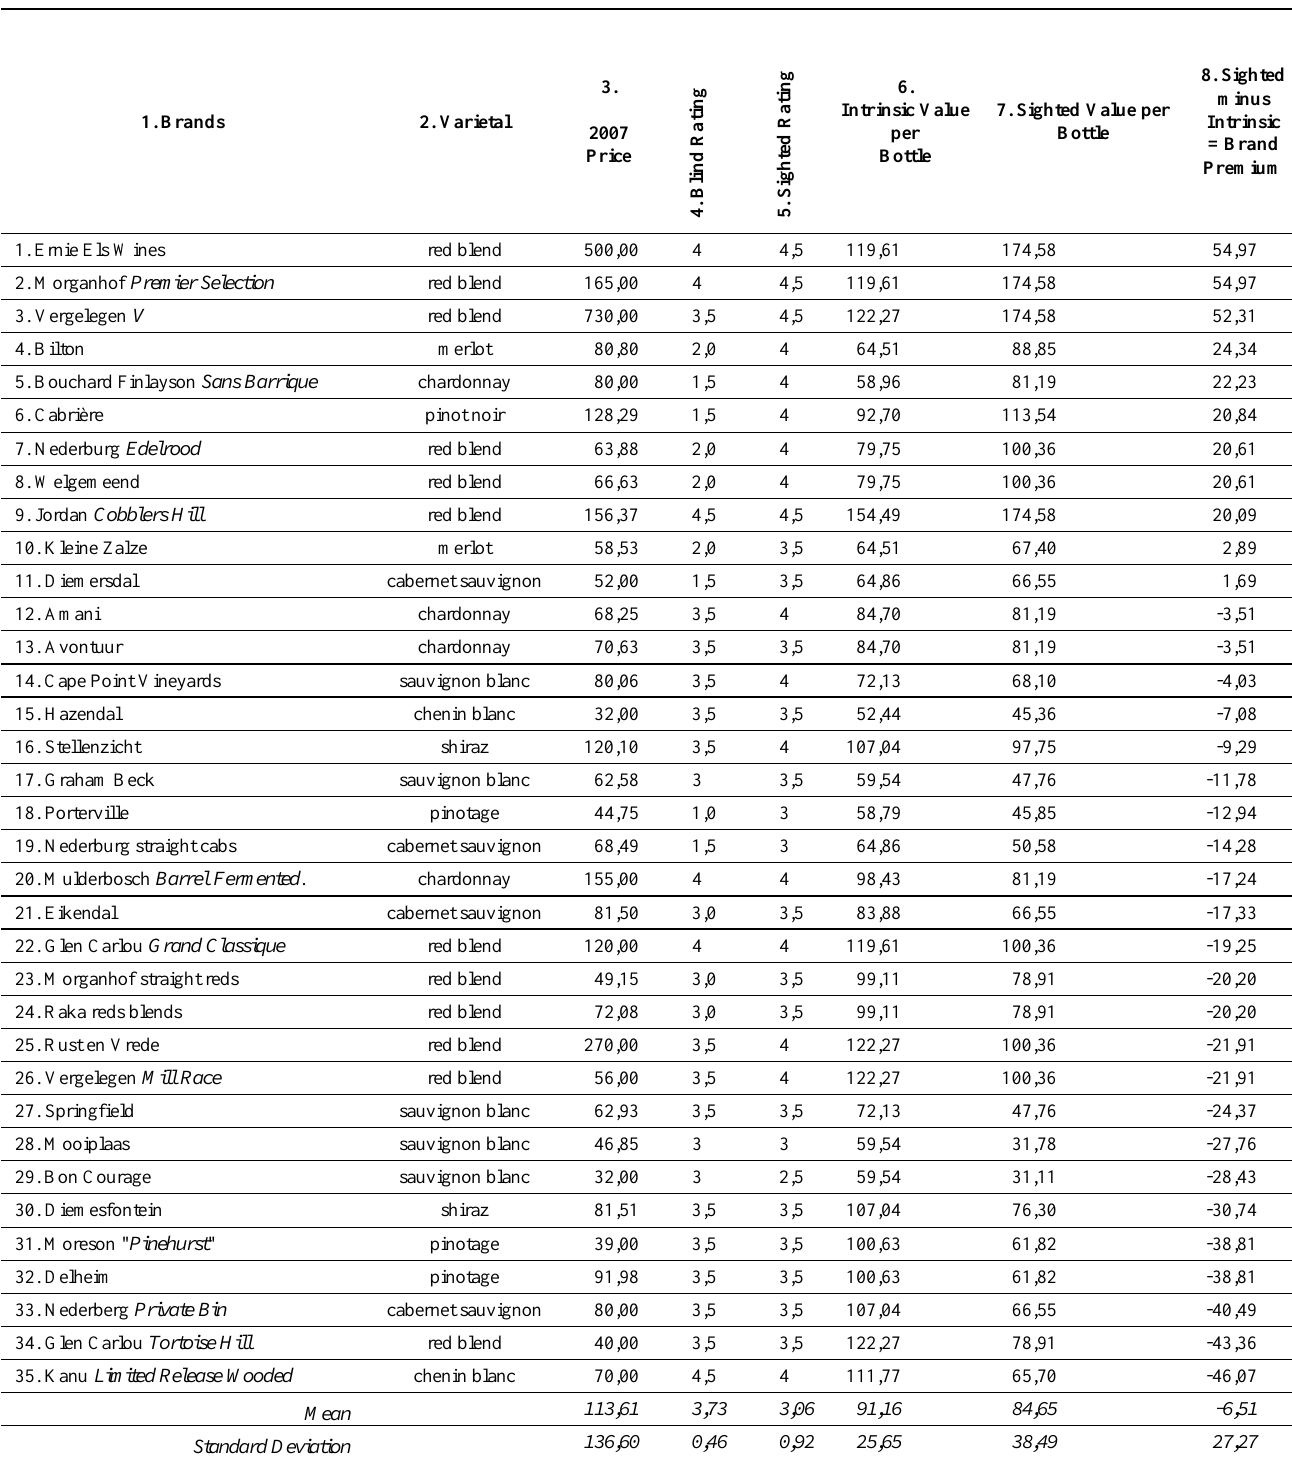
Table 5: Brand premium valuation per bottle as measured by the Quality Premium method. This is the difference between the sighted and intrinsic quality valuations (in Rands). Using the appropriate sighted and blind scores (col. 4 and 5), we calculate their predicted sighted and blind-based valuations per bottle as per the pricing models presented in Table 3. These valuations appear above in columns 6 and 7. Column 8 presents the brand premium valuation by calculating the difference between columns 6 and 7, and the table is ranked by descending order of this